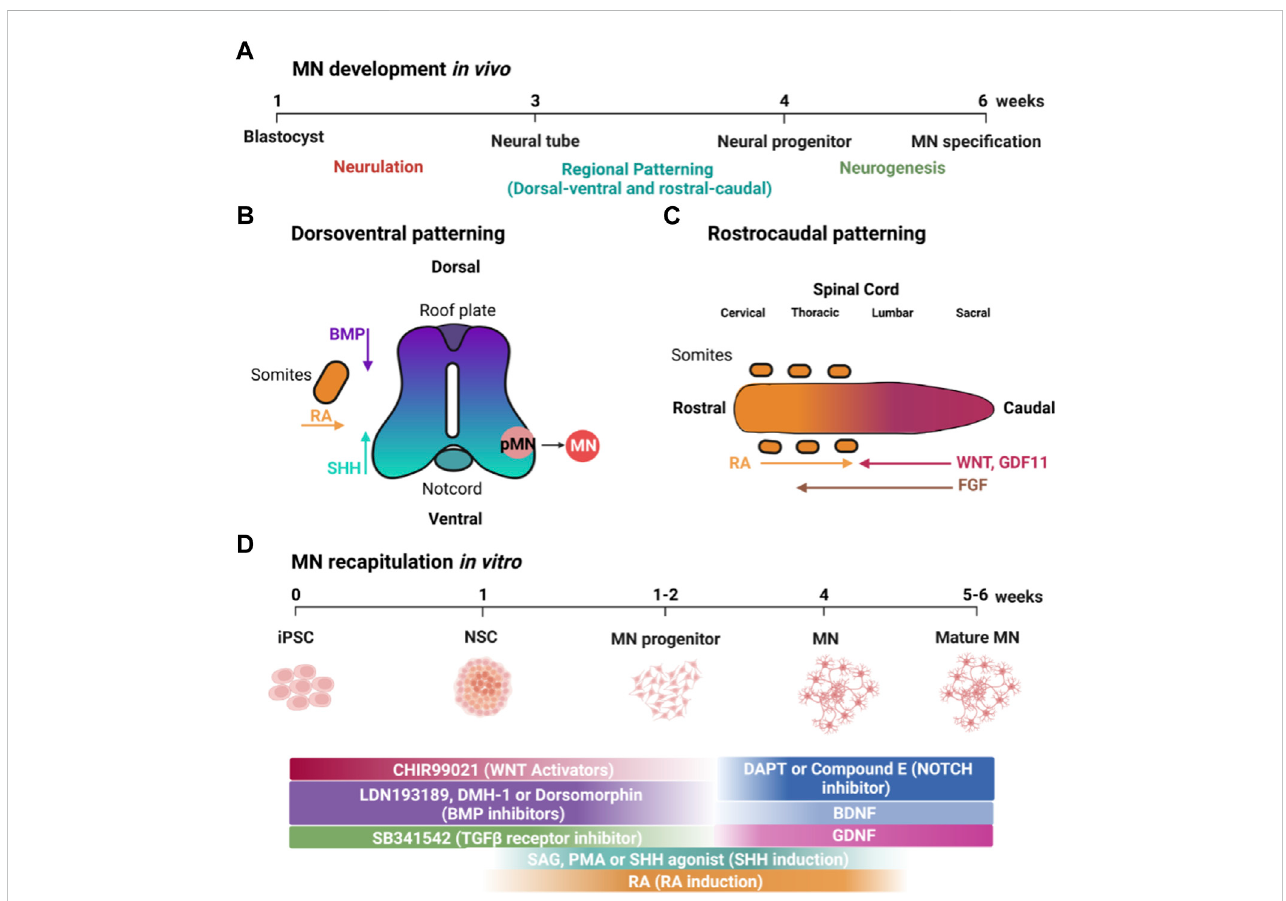
FIGURE 1 MN development in vivo and its recapitulation in vitro using small molecules. (A) Timeline of MN development in vivo . (B) Patterning along the dorsoventral axis is regulated by BMP and SHH produced by the roof and fl oor plates, respectively, as well as RA from adjacent somites. (C) Patterning of the rostrocaudalaxis isregulated byWNT,FGF, GDF11 andRA. (D) Timelineshowing howsmall molecules can beused to recapitulate developmental factors that specify MN development. Created with